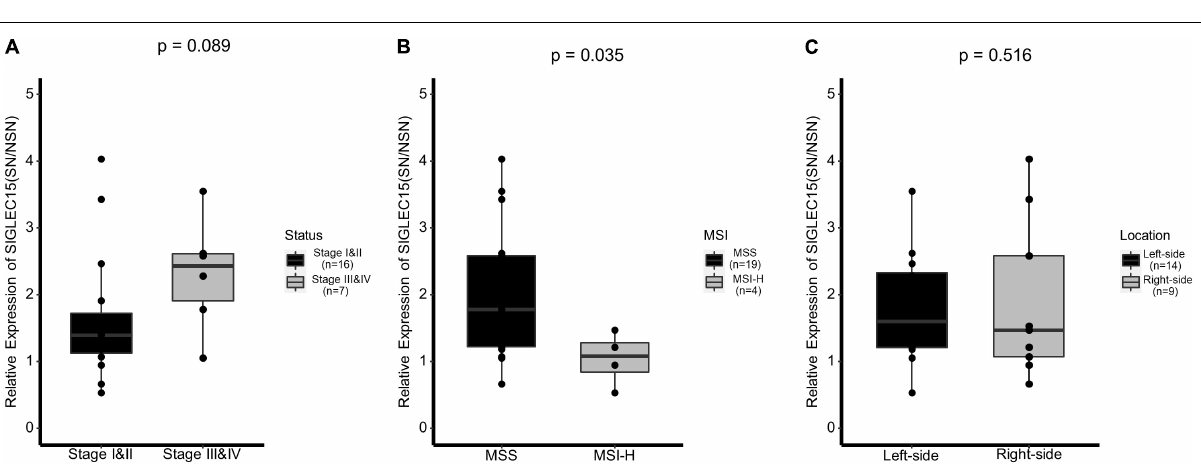
FIGURE 5 | Association of the relative SIGLEC15 mRNA expression (SN/NSN) and three clinical characteristics. (A) Comparison of different clinical stages. (B) Comparison of different microsatellite instability (MSI) statuses. (C) Comparison of different primary tumor locations. MSS, microsatellite stable; MSI-H, microsatellite instability–high. * p < 0.05, with Wilcoxon